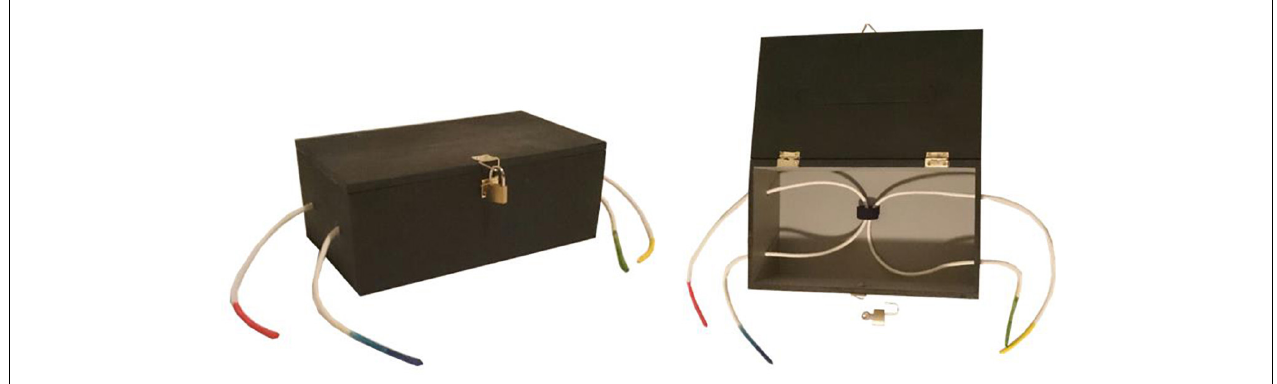
FIGURE 1 | Black-box inquiry task. (A) Closed black-box, as presented to parent–child dyads during inquiry. Four rope ends, with unique colors (red, blue, green, and yellow) stick out. The box is sealed by a padlock. (B) Opened black-box, as presented to parents in the pre-knowledge experimental condition, prior to the inquiry task. Parents could observe two ropes, one with a red and blue rope end and another with a green and yellow rope end interconnected through a fabric